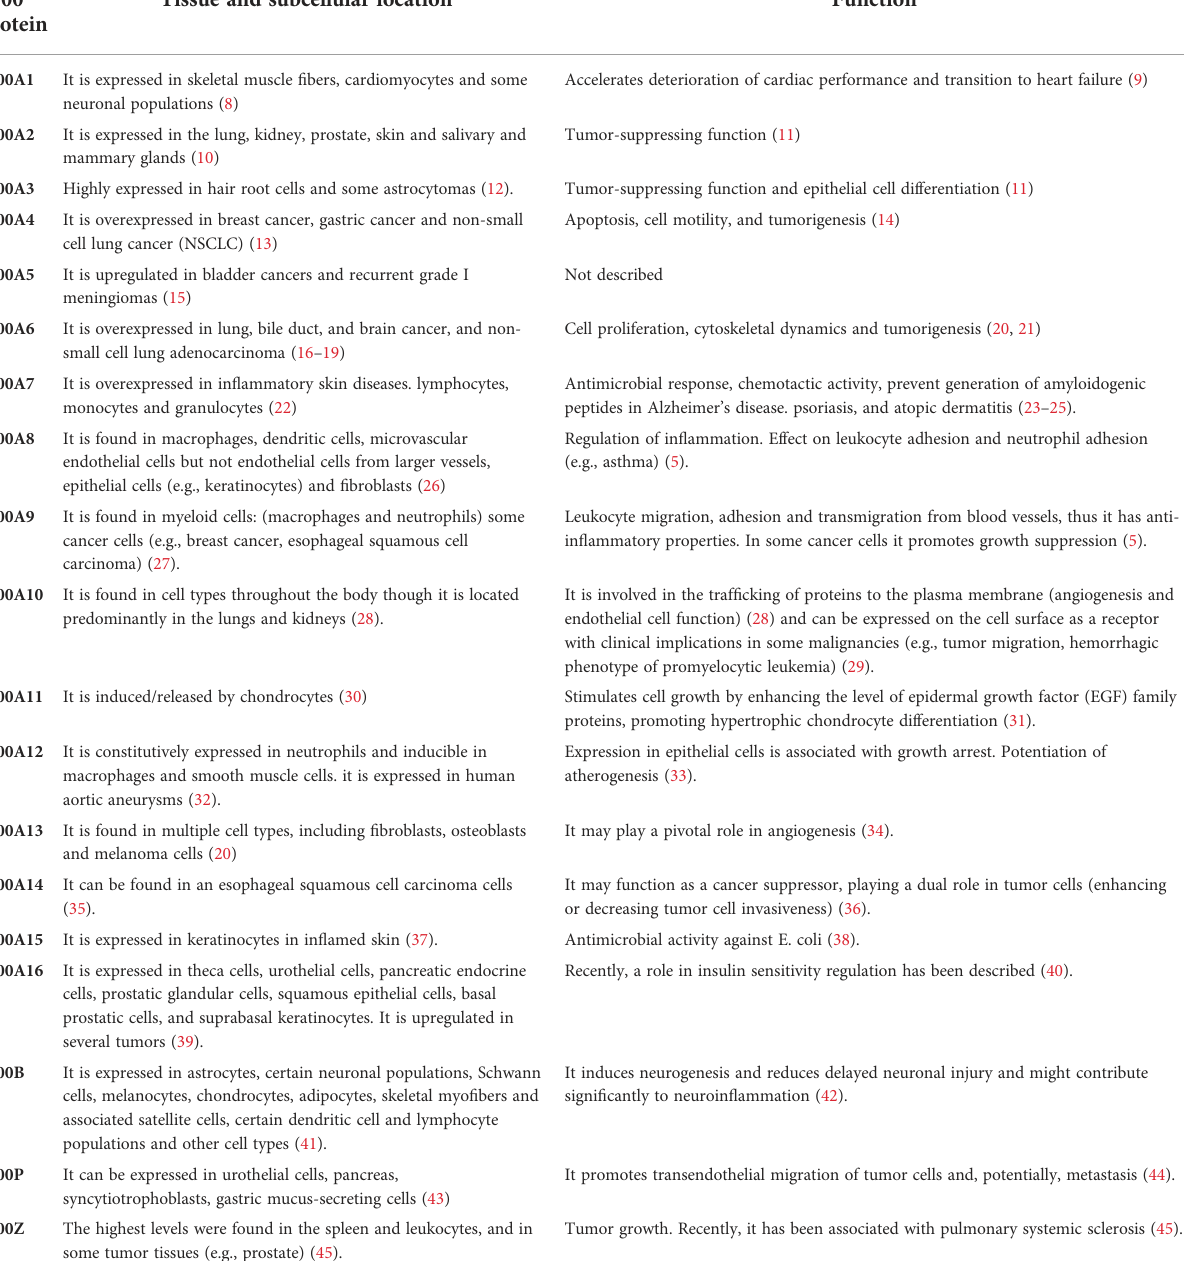
TABLE 1 S100 protein family. Main tissue cell localization and function of S100 protein family. S100 Tissue and subcellular location protein